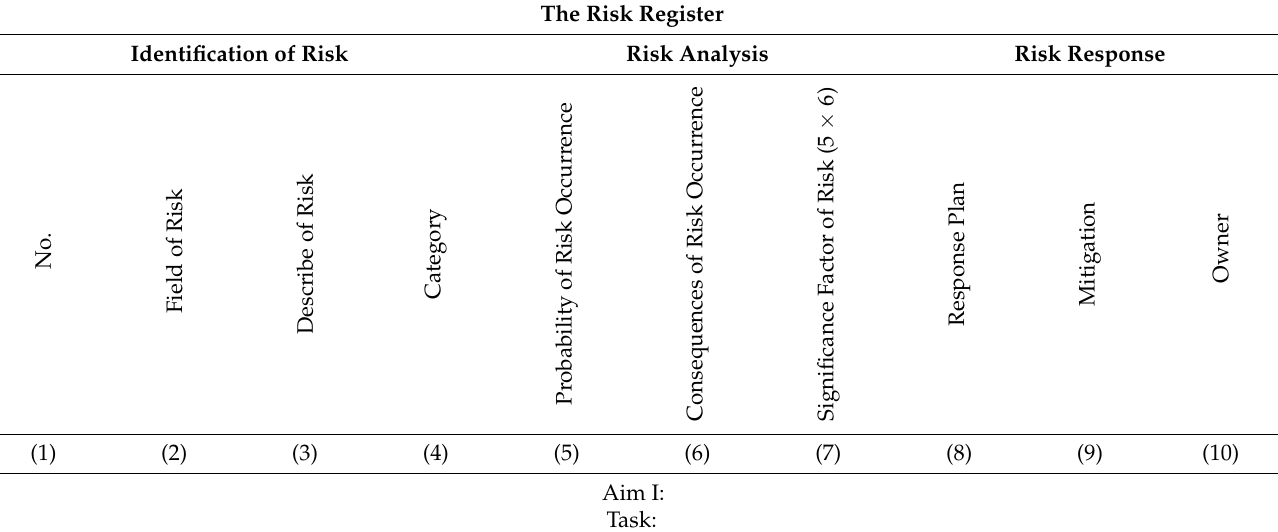
Table 1. Sample risk